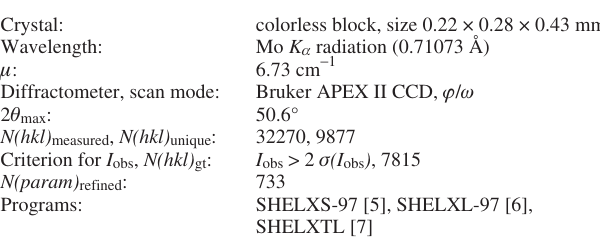
Table 1. Data collection and